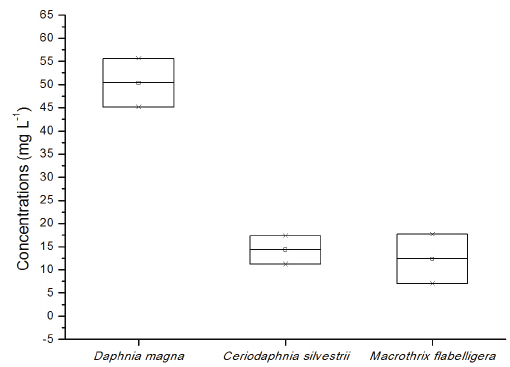
Figure 1. Box-plots representing mean EC - 48h sensi- 50 tivity values ± 2 standard deviations of Daphnia magna, Ceriodaphnia silvestrii and Macrothrix flabelligera to the atrazine Atanor 50 SC® based on three acute toxicity Table 1. Mean values for EC – 48h of atrazine and 95% confidence intervals (inside parenthesis) for the cladocerans 50 Ceriodaphnia silvestrii , Daphnia magna and Macrothrix flabelligera based on the results of three tests performed plus the estimated mean and standard deviation.